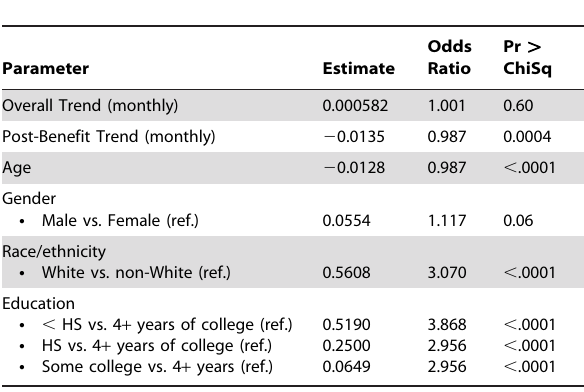
Table 4. Logistic Regression on Smoking Prevalence with Trend and Demographic Independent Variables,